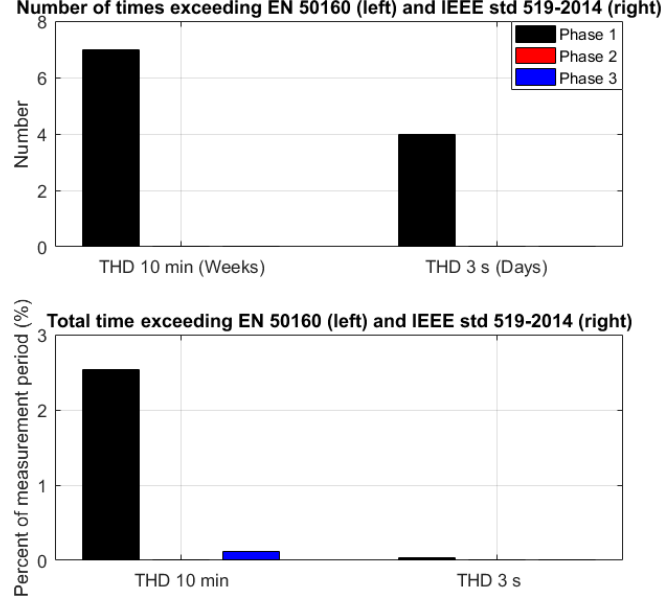
Figure 22. The number of times the voltage THD exceeded the limits in EN 50160 and IEEE 519-2014 for the 10 min (in weeks) and 3 s (in days) ( top ) and the amount of time in which the voltage THD exceeded the 8% and 12% limits in EN 50160 and IEEE 519-2014 ( bottom ) for all three phases during islanded operation. The measurement period was 48 weeks.